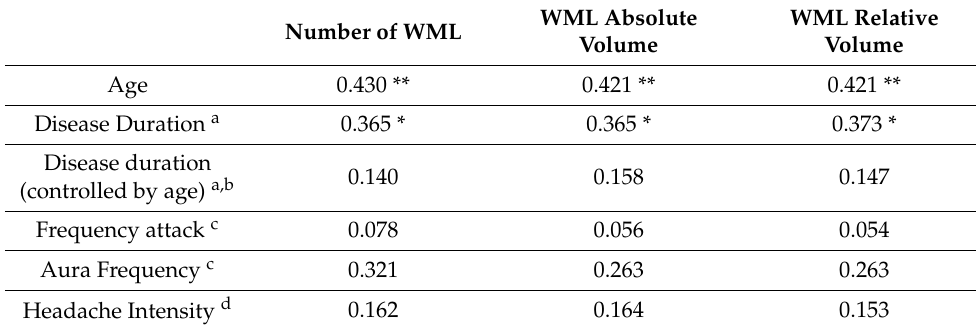
Table 4. Correlations between volumetric parameters (whole brain) and clinical